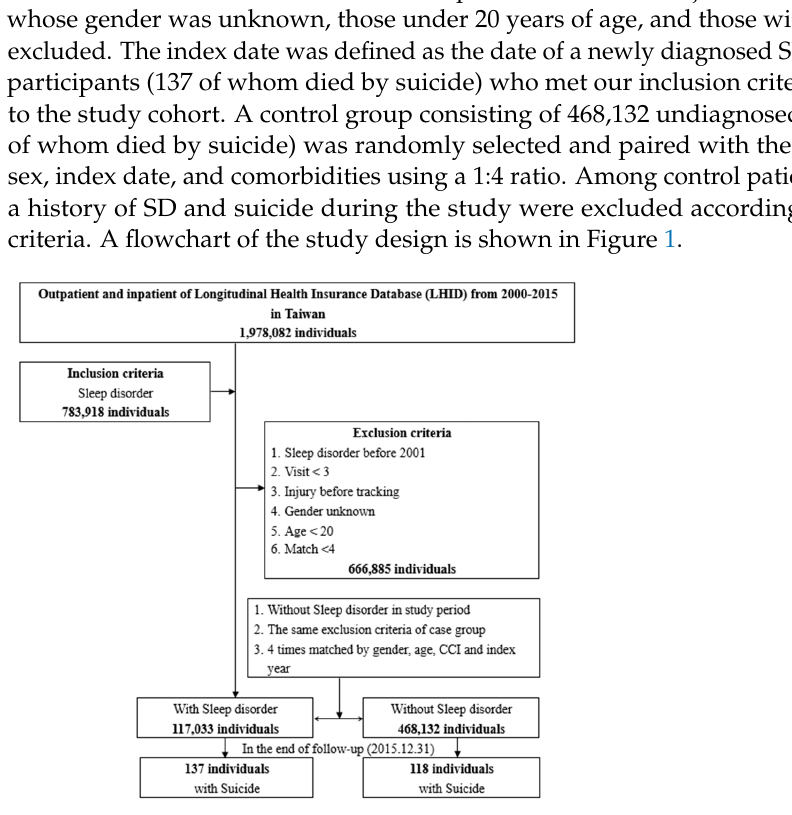
Figure 1. Flowchart of study sample selection from the National Health Insurance Research Database in Taiwan.